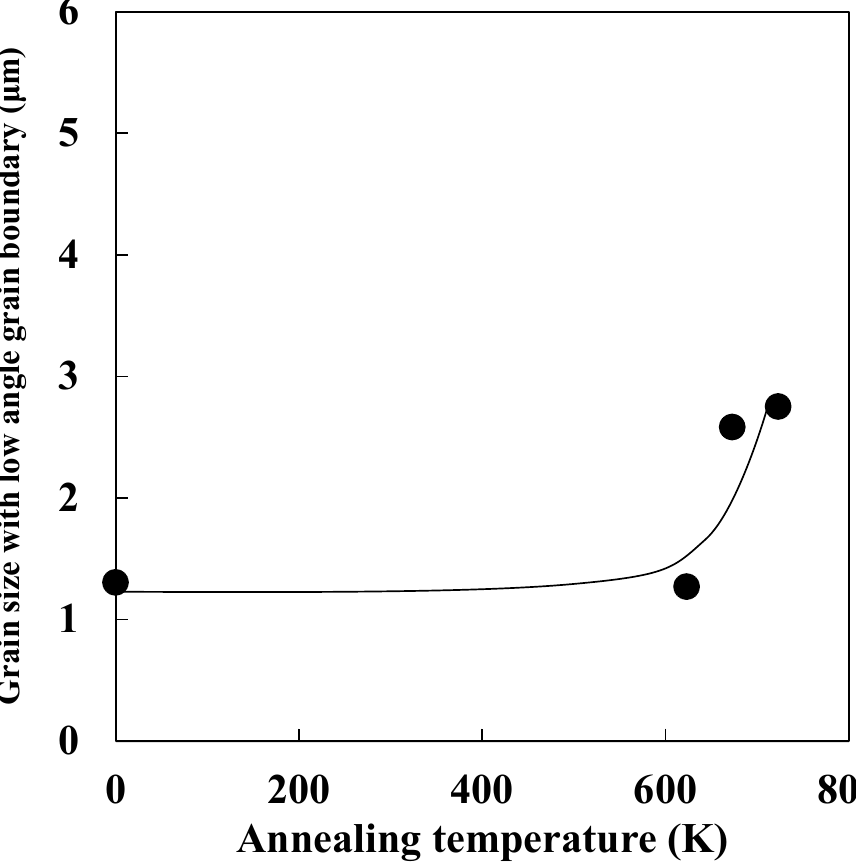
Figure 3. Changes in grain size with low-angle grain boundary during annealing.